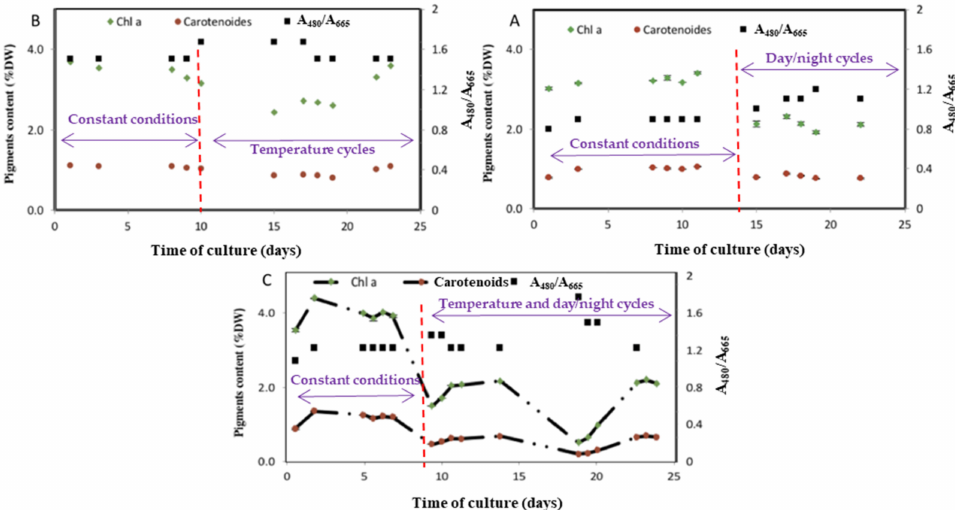
Figure 7. Evolution of the photosynthetic pigment contents of N . sp. QU130 under two different cultivation regimes tested: ( A ): Cultivation under temperature fluctuation cycles; ( B ): Cultivation under day/night cycles; ( C ): Cultivation under combined light and temperature cycles. The ratio of absorbance at 480 and 665 nm (noted A480/A665) represents the “stress factor”, which is proportional to the carotenoid and chlorophyll content (see text for further